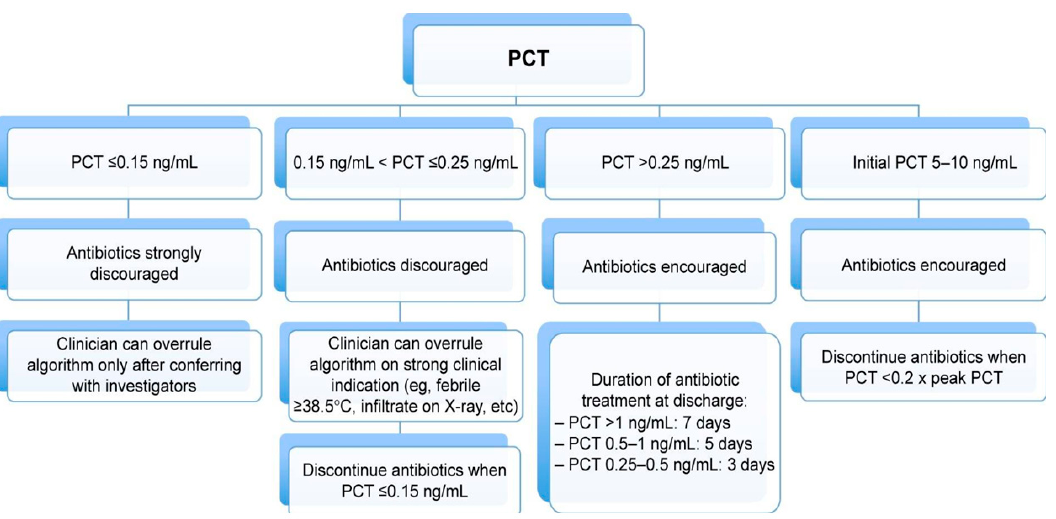
Figure 2. Suggestion of a PCT-guided antibiotic discontinuation algorithm based on Corti et al.